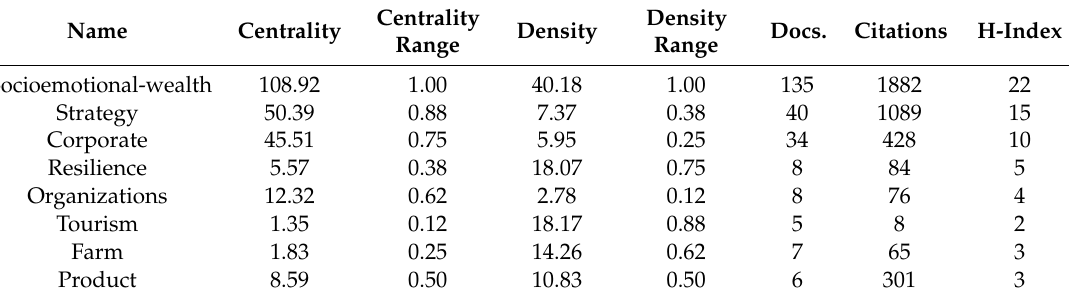
Figure 4. Strategic Maps and Thematic network of Socioemotional-Wealth. Primary Documents period 2003–2009. Source: Prepared by the authors on the basis of SciMAT data. Table 5. Cluster period 2003–2019.